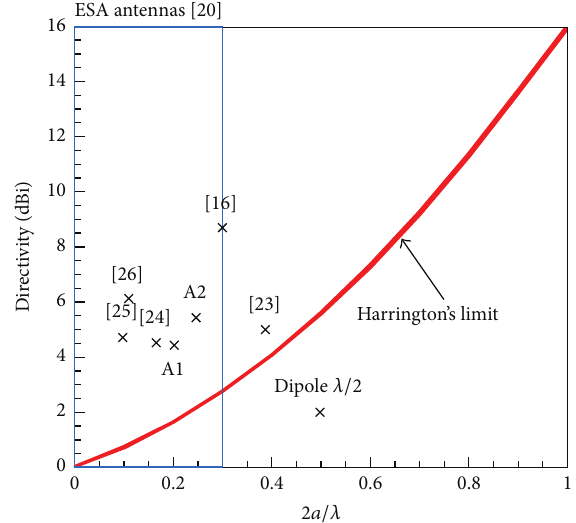
Figure 6: Position of simulated maximum directivities of the structure with its two configurations A1 and A2 in the chart representing the directivity versus the antenna